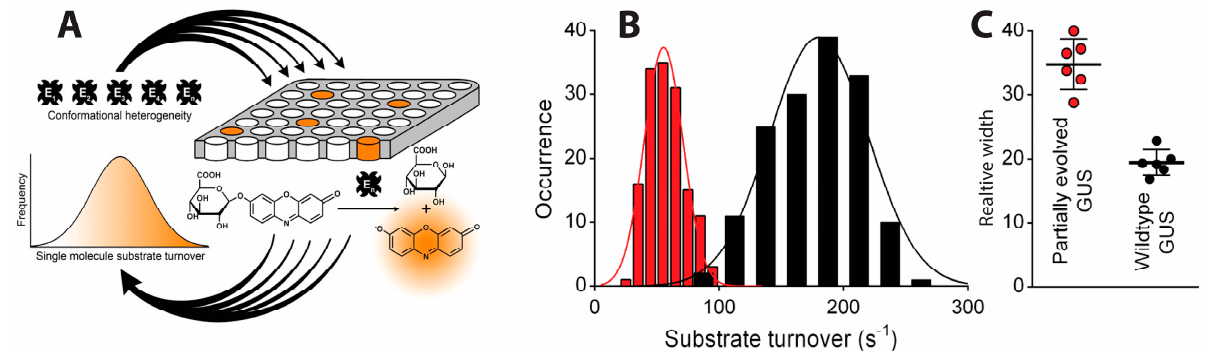
Figure 6. Single molecule insights on the functional diversity of enzymes. ( A ) high density arrays of 62,500 fL reaction chambers to simultaneously interrogate the activity of hundreds of individual enzymes. The nonfluorescent substrate ReG is converted to the highly fluorescent product resorufin that is detected by fluorescence microscopy. The method allows observation of the existence of long lived functional states; ( B ) Widths of distributions of the sampled activity states for the wild type (black) and partially evolved GUVs following in both cases Gaussian distributions, but having variable widths ( C ) Relative widths of distributions (coefficient of variation) of multiple independent experiments showing the activity of the partially evolved GUVs to be significantly more widely distributed as compared the wild type enzyme (reprinted with permission from